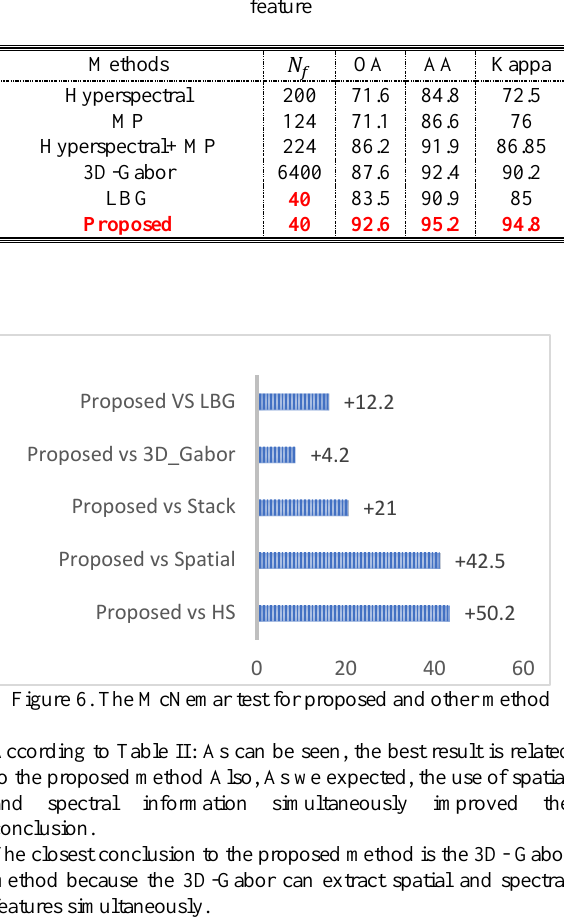
Table II. Results on Indian Pines Data Set. 𝑁 𝑓 is number of